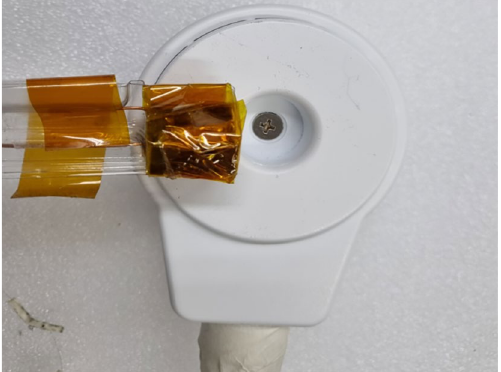
Figure 13. Measurement setup of electric field intensity of fabricated